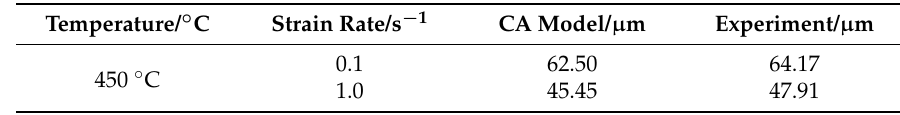
Figure 10. Changes in the recrystallized volume fraction as a function of delay time.